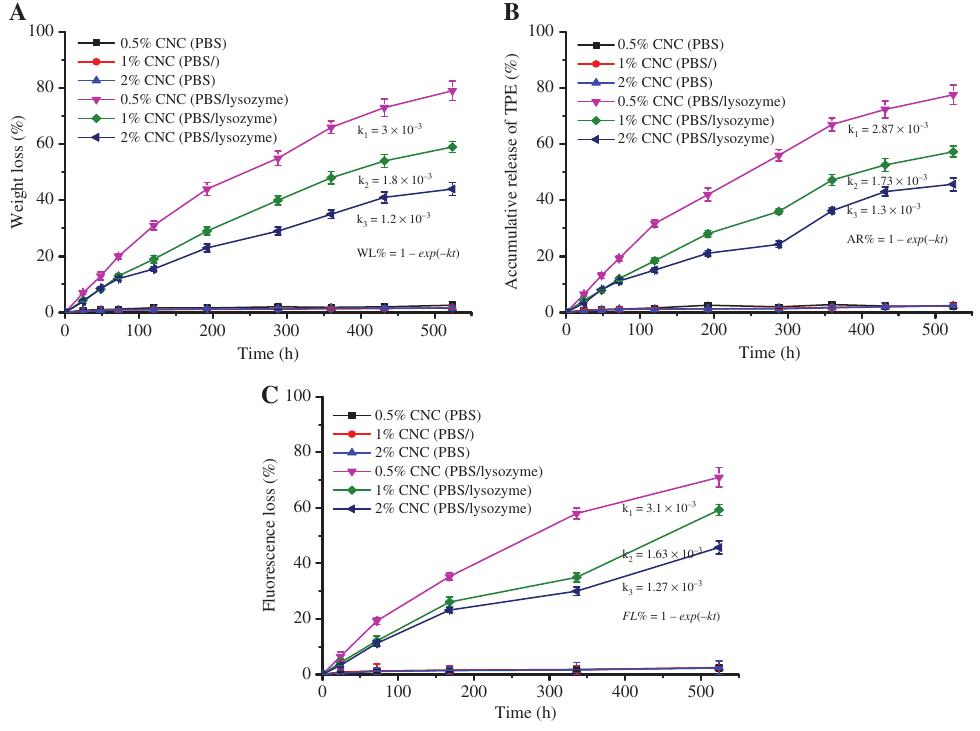
Figure 5: In vitro degradation of DEX/CCNC/MPDA-TPE hydrogels. (A) Gravimetric degradation of hydrogel S and (B) release behavior of TPE in the absence of lysozyme or in the presence of lysozyme over time. (C) Quantitative fluorescence reduction of different hydrogels in vitro degradation in the absence of lysozyme or in the presence of lysozyme over time.